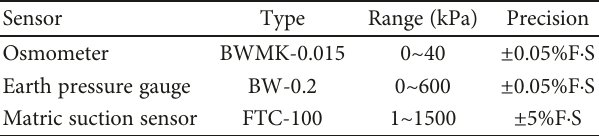
Table 1: Test instrument